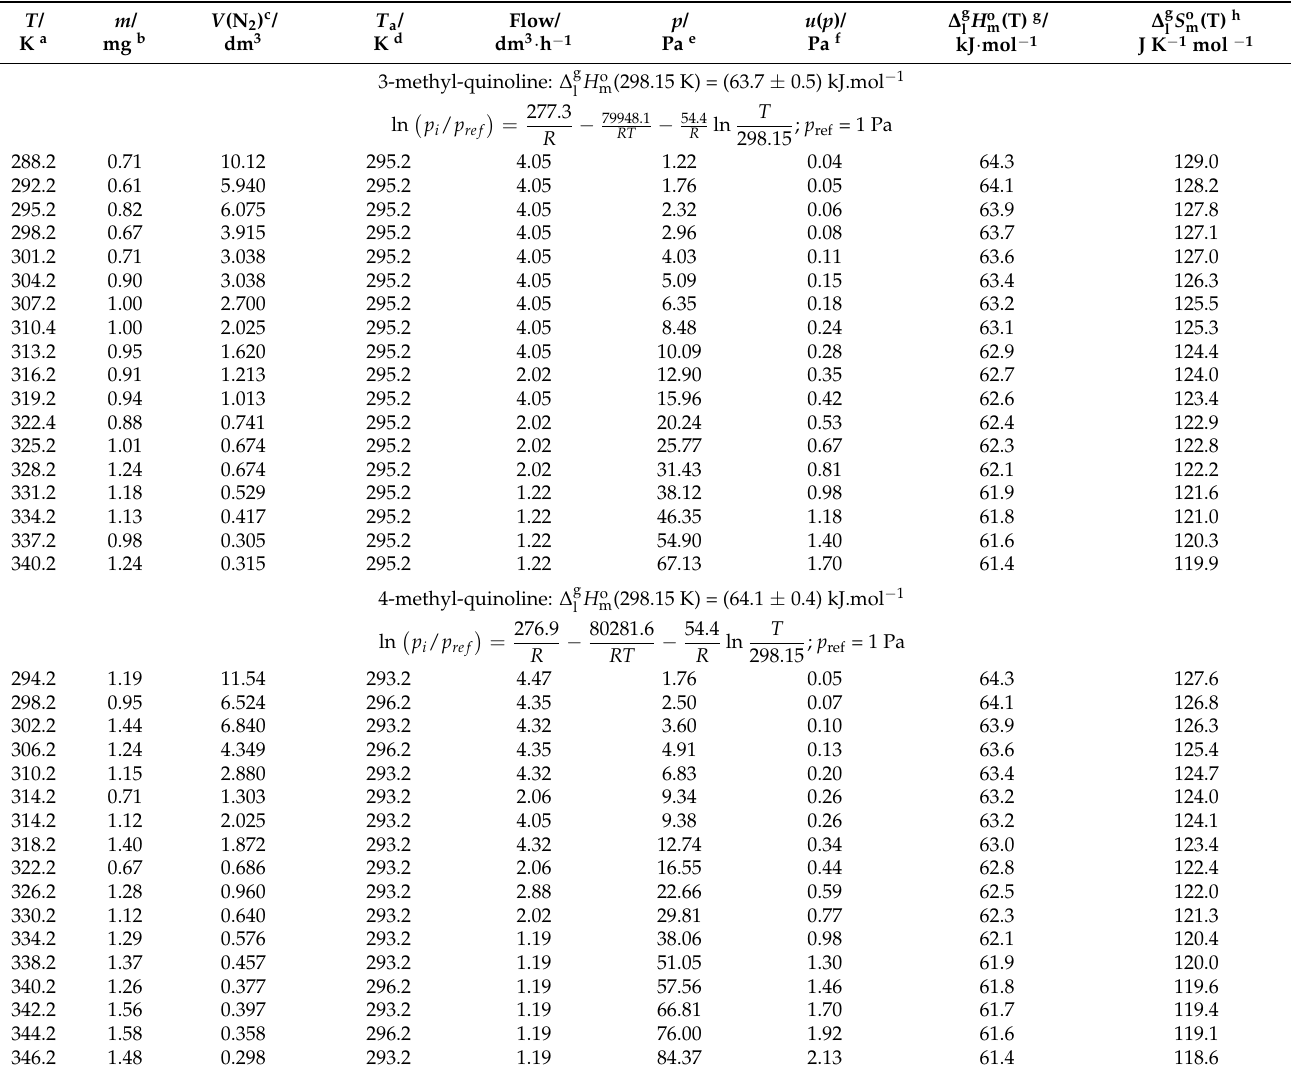
Table 1. Results of transpiration method for quinoline derivatives: absolute vapor pressures p i , standard ( p o = 0.1 MPa) molar vaporization enthalpies and standard ( p o = 0.1 MPa) molar vaporization